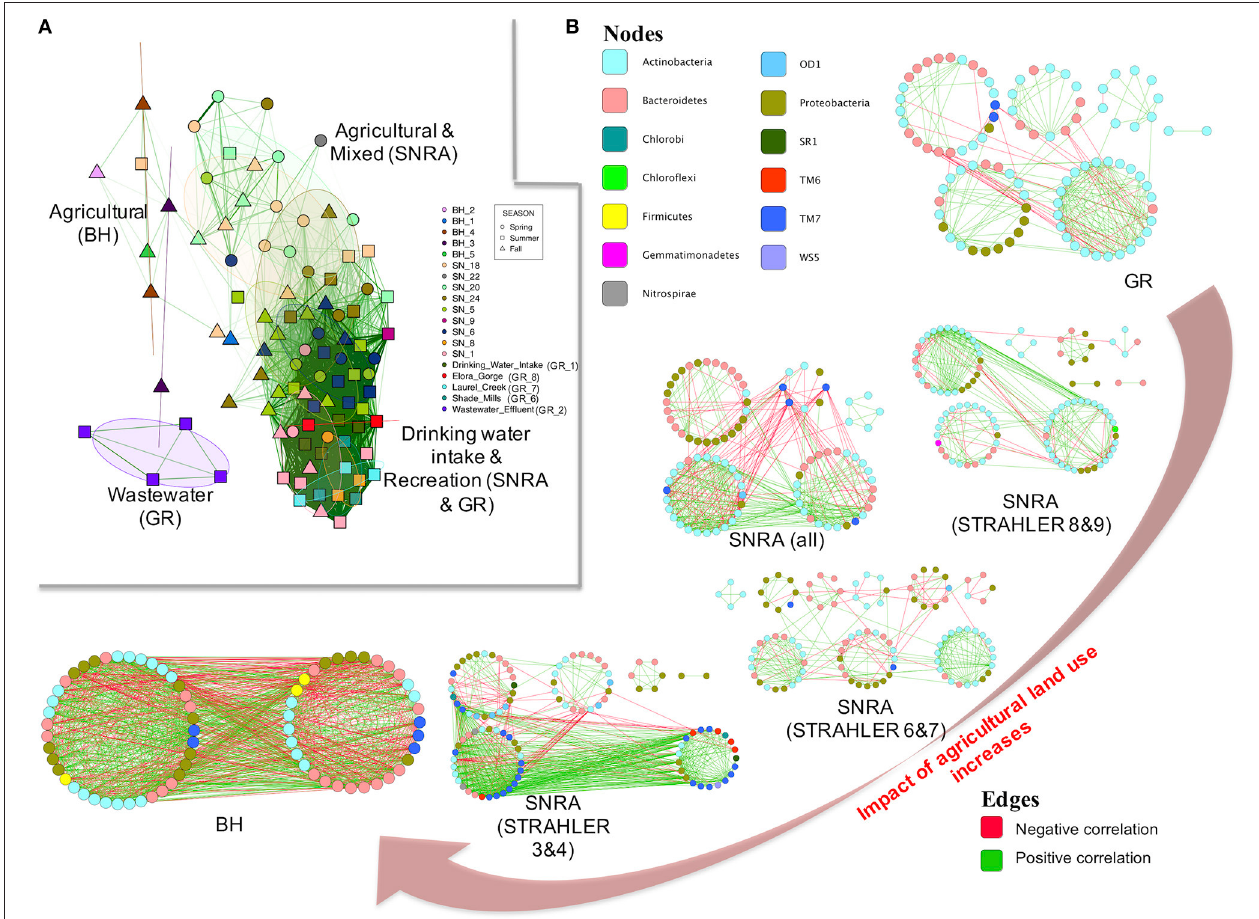
FIGURE 7 | (A) A network showing similarity of the bacterial communities recovered at each sampling site. Each symbol represents one sample. Samples sharing more than 30% community similarity were connected by green edges and were placed closer to each other; the darker the edges, the higher the community resemblance. The overlaid circles are 50% confidence regions of ellipses of samples from each sampling site. (B) Ecological association networks of 97%-identity OTUs at SNRA, BH, and GR based on RMT-approach. The size of each node (OTU) is proportional to the degree (linked edges). The color of each node was determined by phylum. The green edges represent positive correlations between two nodes, while red edges represent negative correlations. The network plots are arranged by the proportion of agricultural land uses around the sampling watersheds.